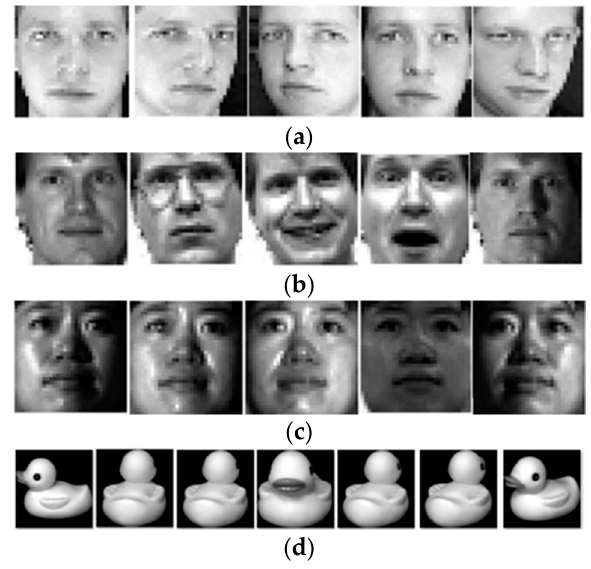
Figure 7. The sample images of public datasets used in our experiment. ( a ) The ORL dataset; ( b ) The Yale database; ( c ) The CMU PIE dataset; ( d ) The COIL20 dataset.